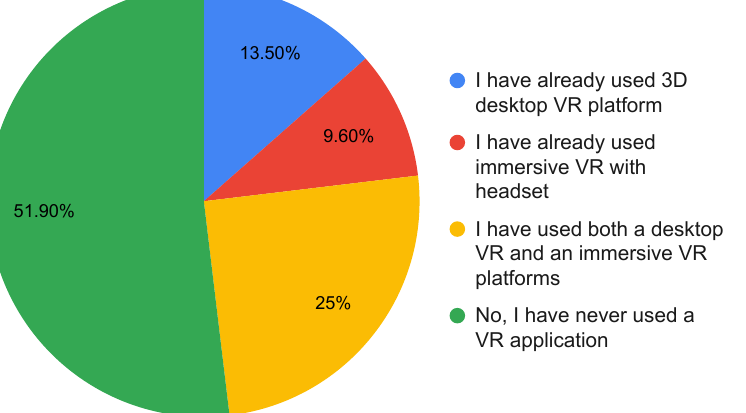
Figure 5. Proportion of the respondents previous experiences with VR systems either desktop or